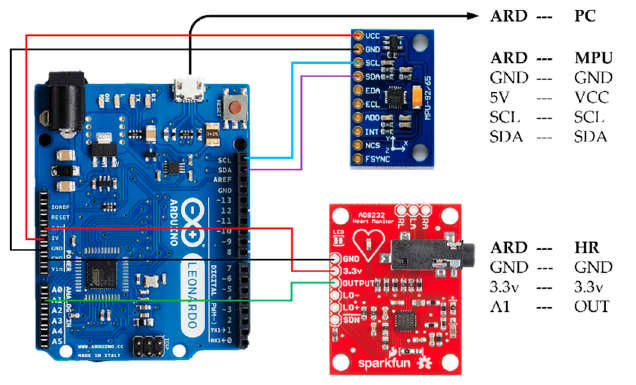
Figure 1. System configuration between the MPU-9250 [49], AD8232 [50], and Arduino Leonardo [51].